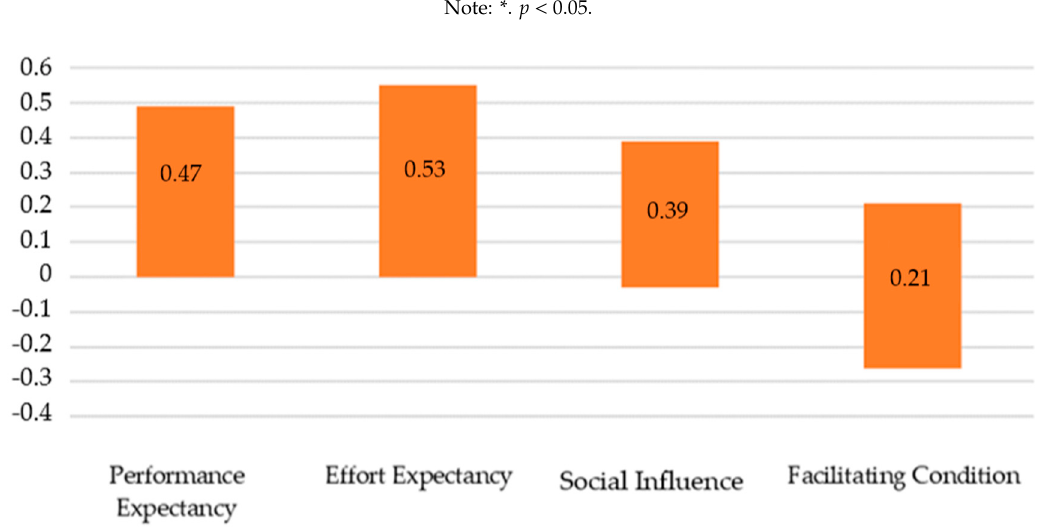
Figure 3. Confidence intervals B for individual predictors . Table 3. Regression coefficients – impact of UTAUT factors on e-prescribing frequency.